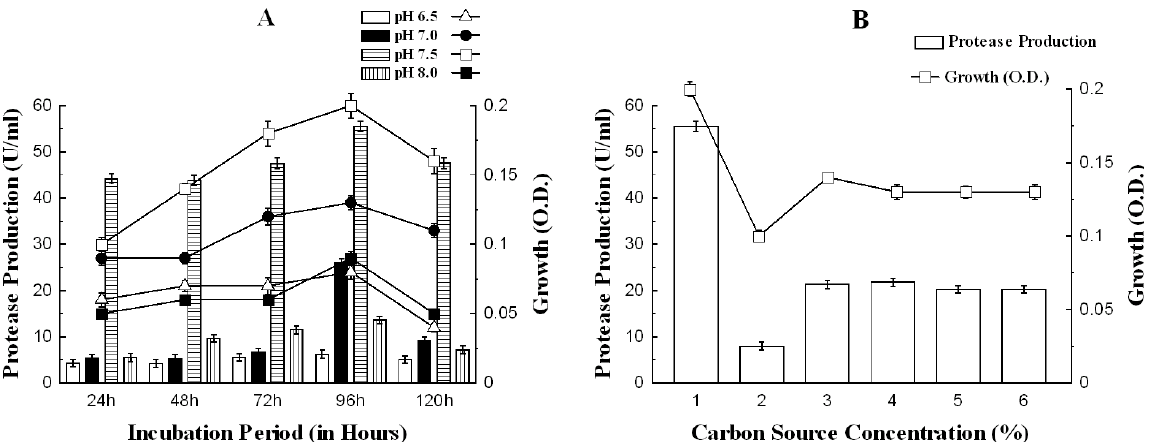
Figure 3. Extracellular enzyme production by selected isolate Bacillus subtilis D3L/1. Bar represents enzyme concentration (U/mL),line graph represents bacterial growth; ( A ): effect of pH and incubation period. ( B ): effect of Carbon source concentration. The statistical significance was p < 0.05.